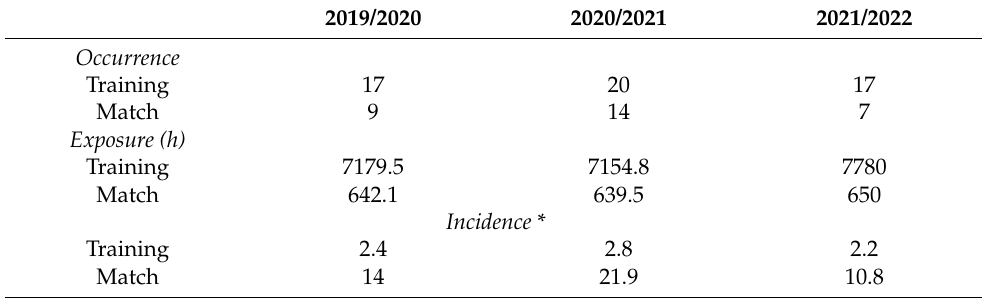
Table 5. Injury occurrence, exposure, and incidence during three consecutive sporting seasons.